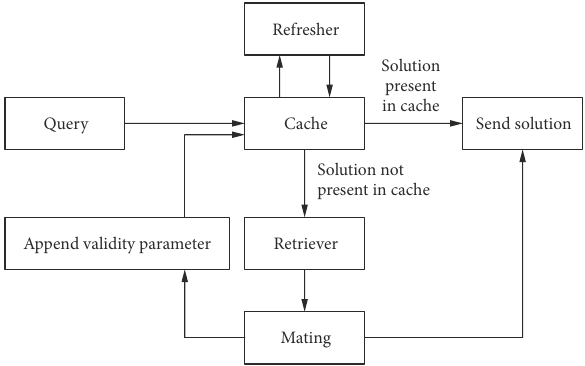
Figure 7. Schematic diagram of the